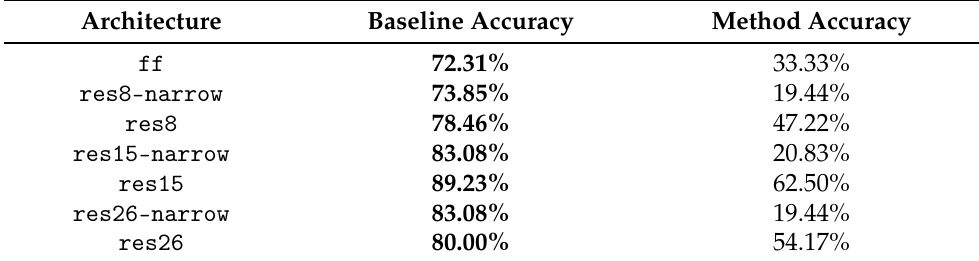
Table 14. Test accuracy on Lithuanian commands after using Google Speech Commands data set [38] as additional target samples. The best result for each architecture is